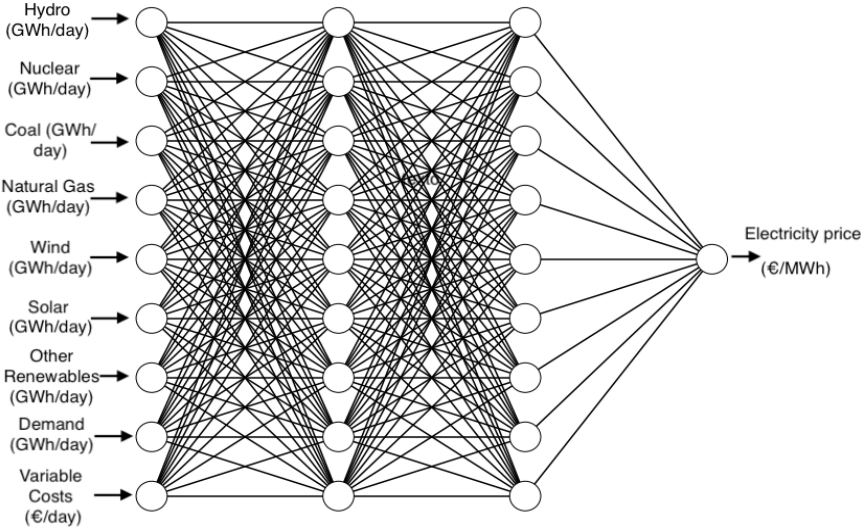
Figure 1. Schematic representation of the ANNs.